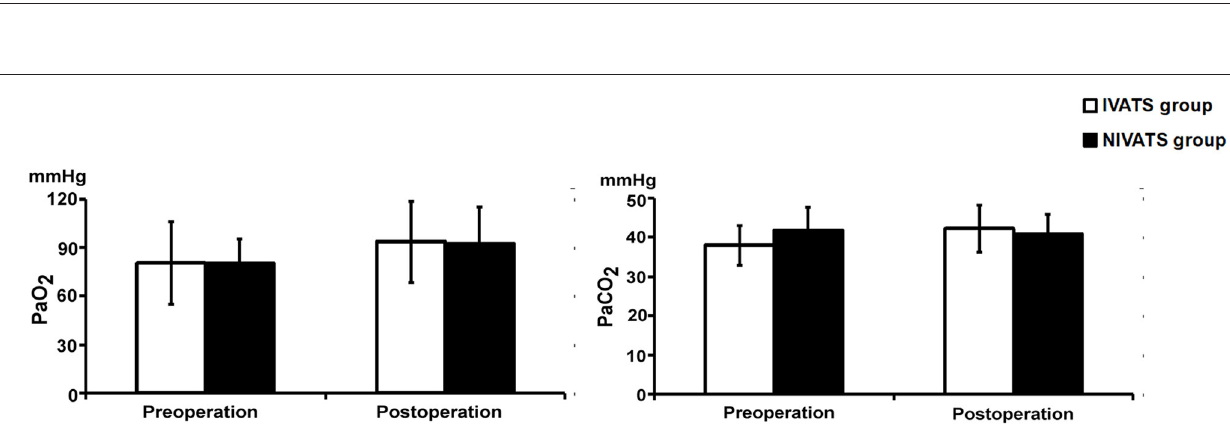
FIGURE 3 | Blood gas values changed in the IVATS group and NIVATS group. Before and after operation, the PaO 2 (Left) and PaCO 2 (Right) of the two groups were compared. No significant difference of preoperative and postoperative values between the two